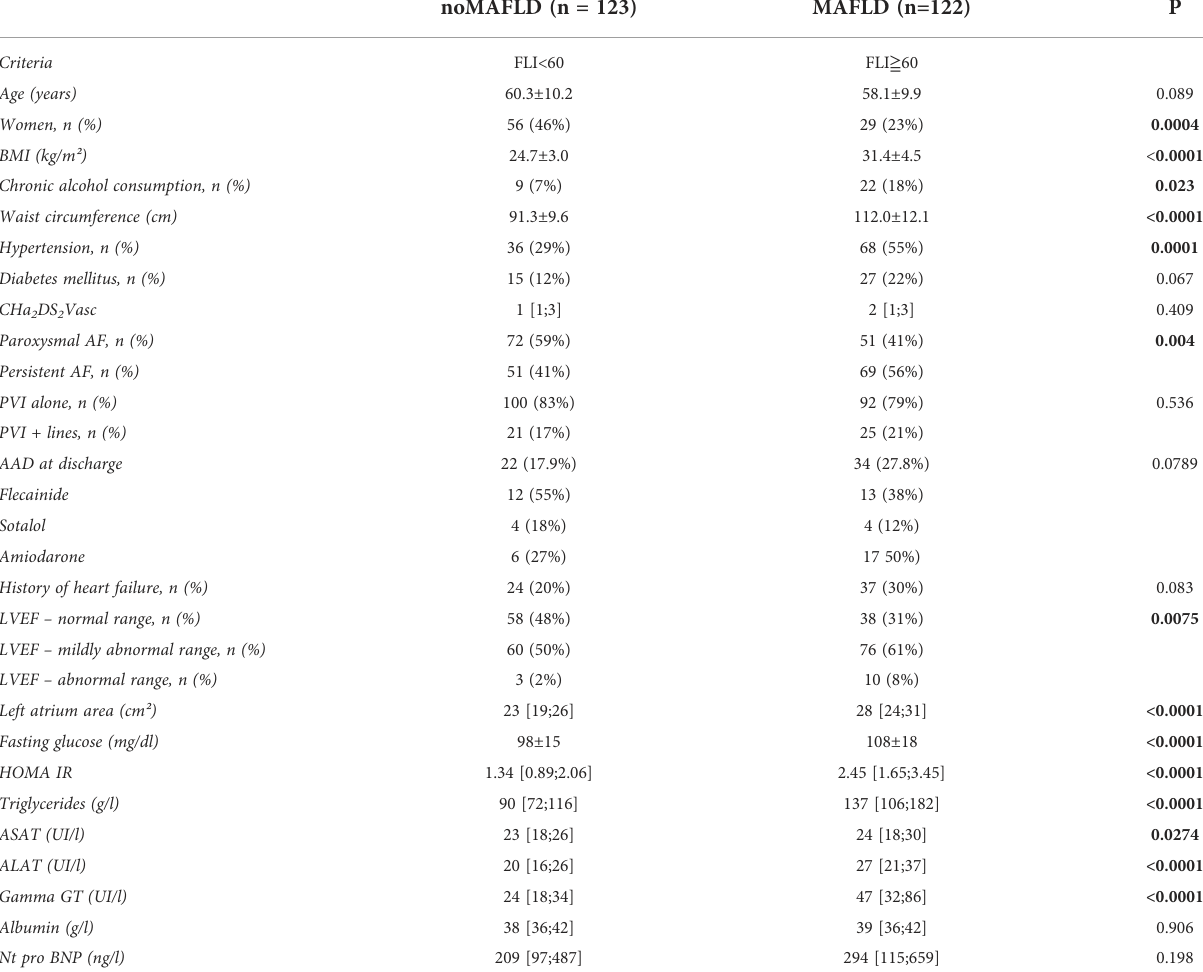
TABLE 1 Baseline characteristics According to MAFLD